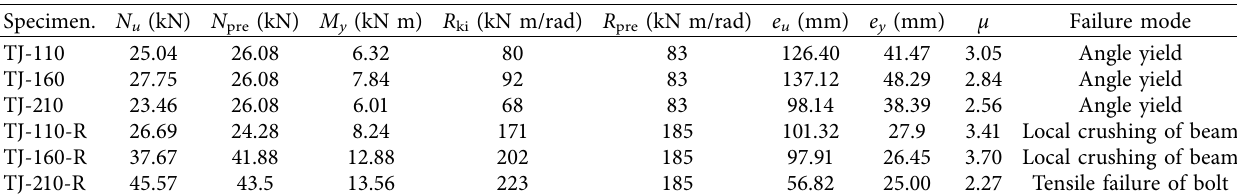
Figure 6: Test setup: (a) photograph and (b, c) schematic diagrams. Table 4: Summary of test